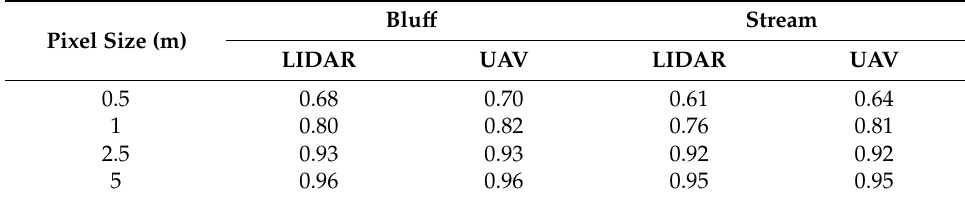
Table 12. Moran’s coefficients of the obtained results.